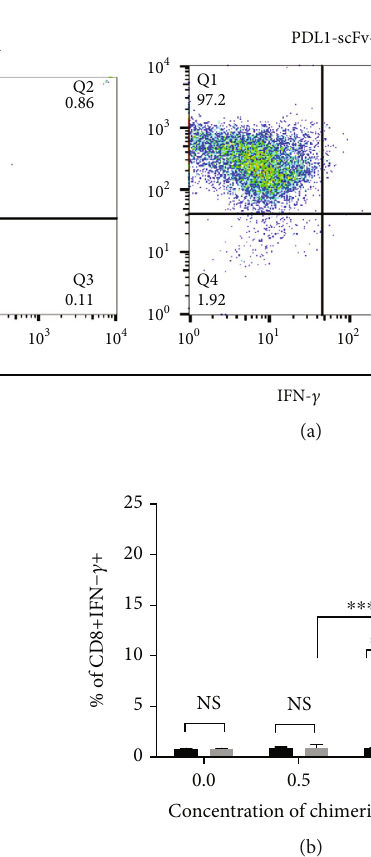
Figure 3: Activation of E7-speci fi c CD8+ T cells by ID8-luc cells pretreated with PDL1-scFv-Fc or PDL1-scFc-Fc-RE7. (a) Representative fl ow cytometry analysis to demonstrate the activation of E7-speci fi c CD8+ T cells following the incubation of ID8-luc cell pretreatment either 50 μ g/mL of PDL1-scFv-Fc or PDL1-scFc-Fc-RE7. ID8-luc cells without treatment are included as a negative control. E7-speci fi c CD8+ T cell activation was determined by CD8 and IFN- γ staining. (b) Representative bar graph depicting the % of IFN- γ -secreting E7- speci fi c CD8+ T cells out of total E7-speci fi c T cells ( mean ± SD ). p values are indicated as one star ( ∗ ) if p < 0 : 05 , two stars ( ∗∗ ) if p < 0 : 01 , and three stars ( ∗∗∗ ) if p < 0 : 001